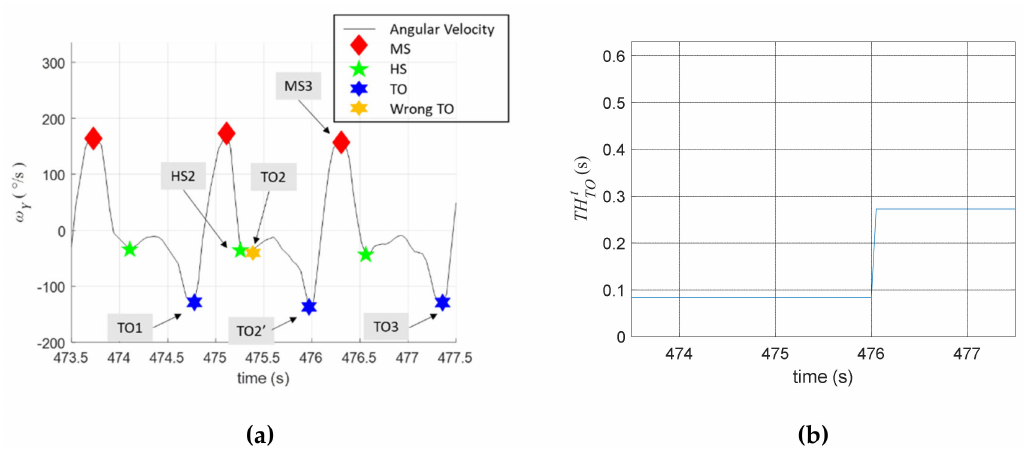
Figure 6. Identification of the TO events. ( a ) Labelling of the TO events; ( b ) online adjustment of TH t